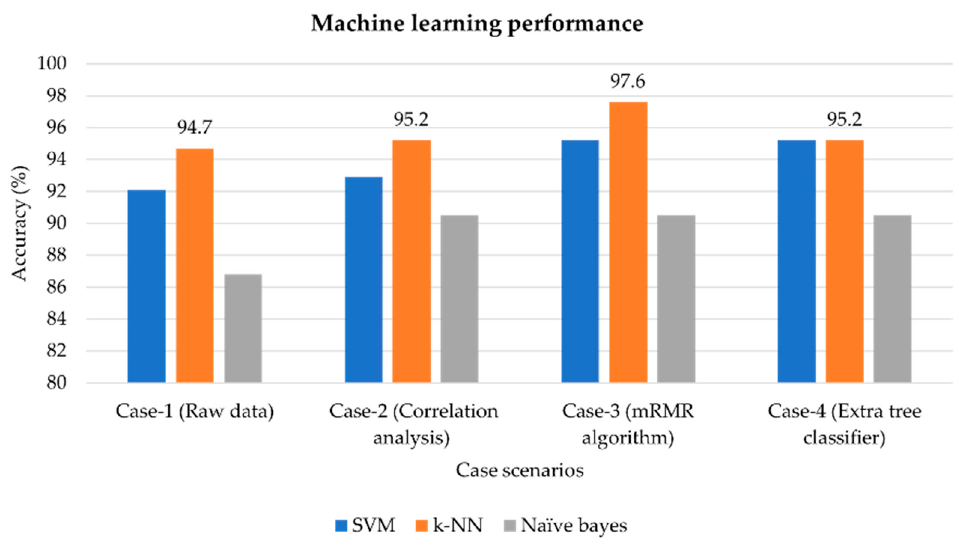
Figure 11. Machine-learning performance comparison of the four data case scenarios.